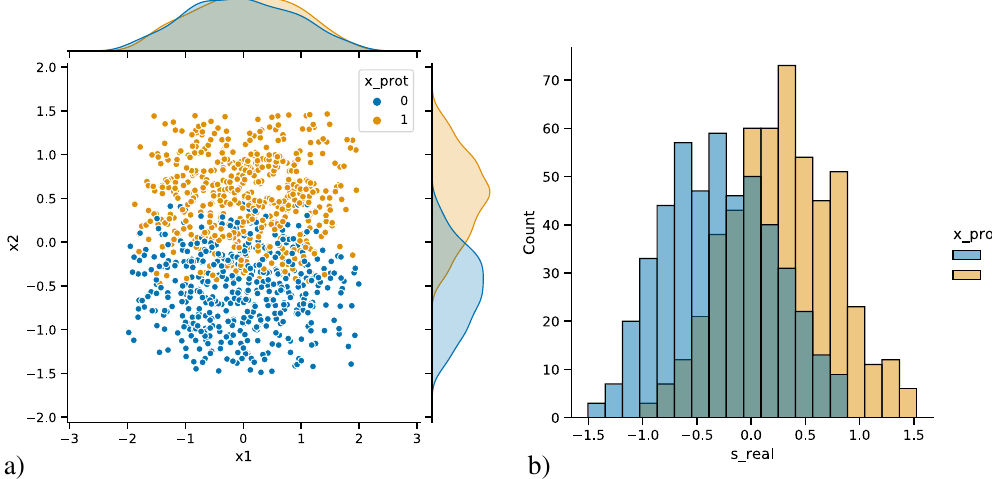
Figure 1. Sample of the background-population ( a ) Distribution of the two skill features, ( b ) Distribution of total skills ( s real ), both split up according to the binary protected attribute. In ( b ), both colors are half- transparent, and the overlapping region is therefore depicted by the mixed